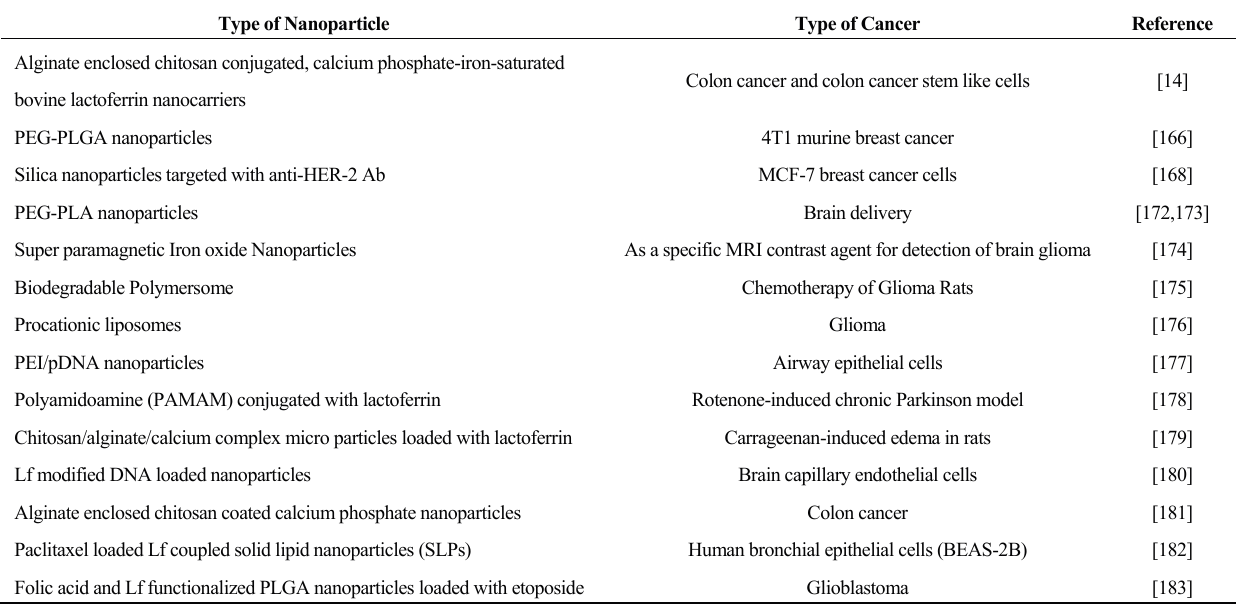
Table 2. Various types of nanoparticles used for lactoferrin